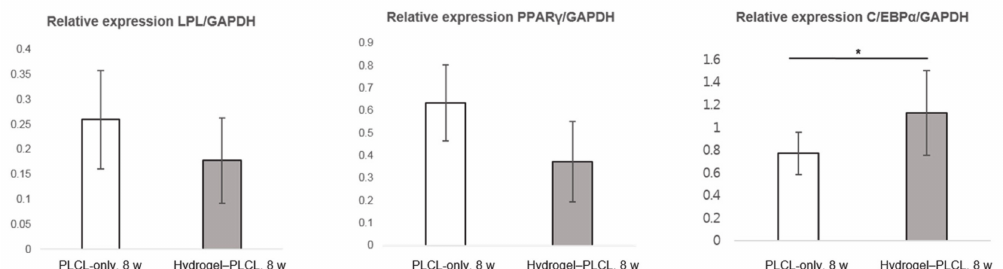
Figure 12. Analysis of quantitative real-time polymerase chain reaction results. Relative mRNA expression of LPL, PPAR γ and C/EBP α in the PLCL-only scaffolds and the hydrogel–PLCL complex constructs (* p <